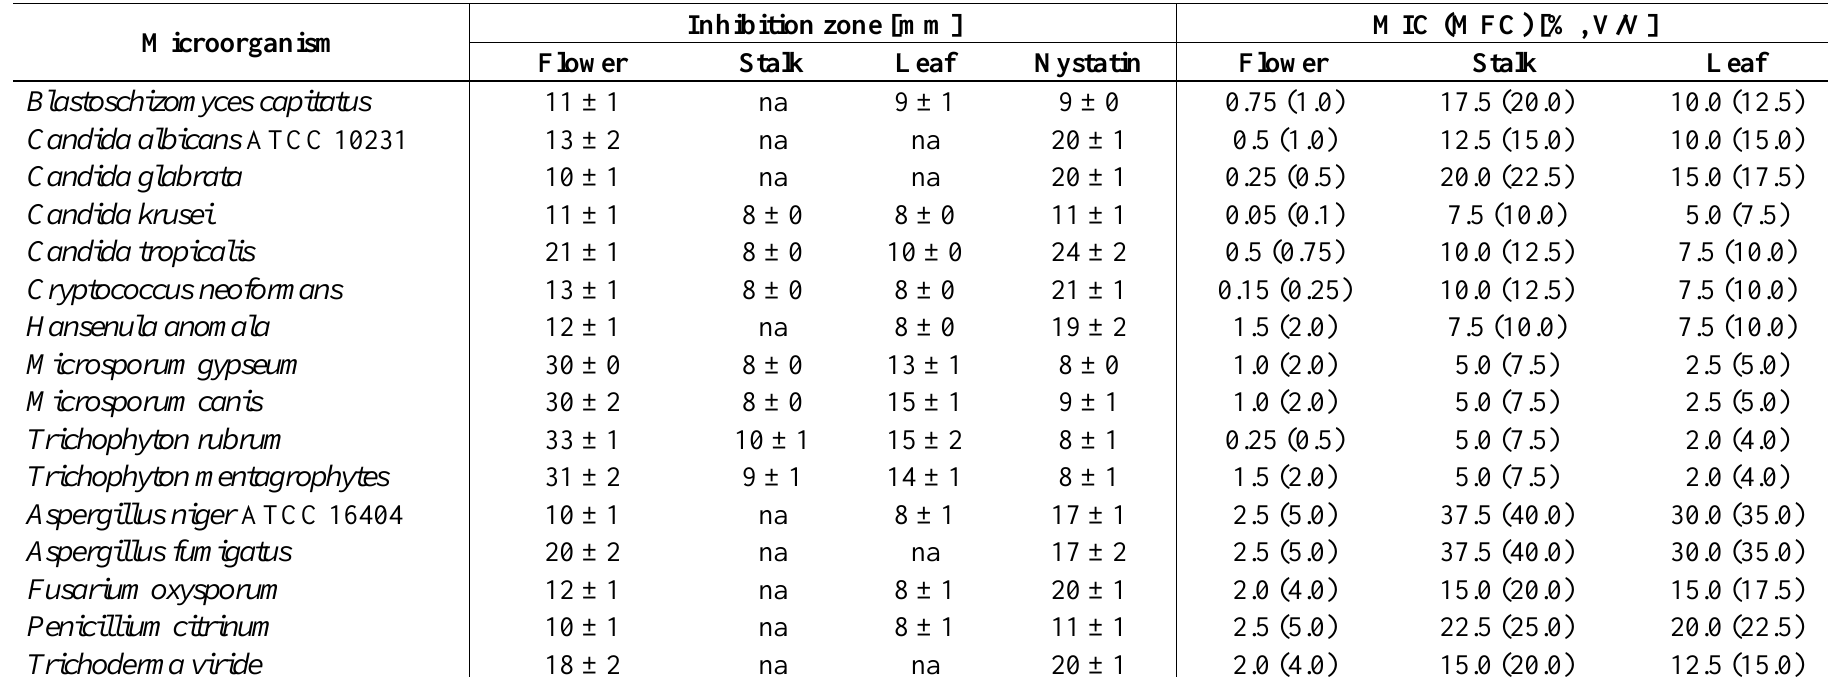
Table 3. Antifungal activity of Lavandula · intermedia ‘Budrovka’ ethanolic